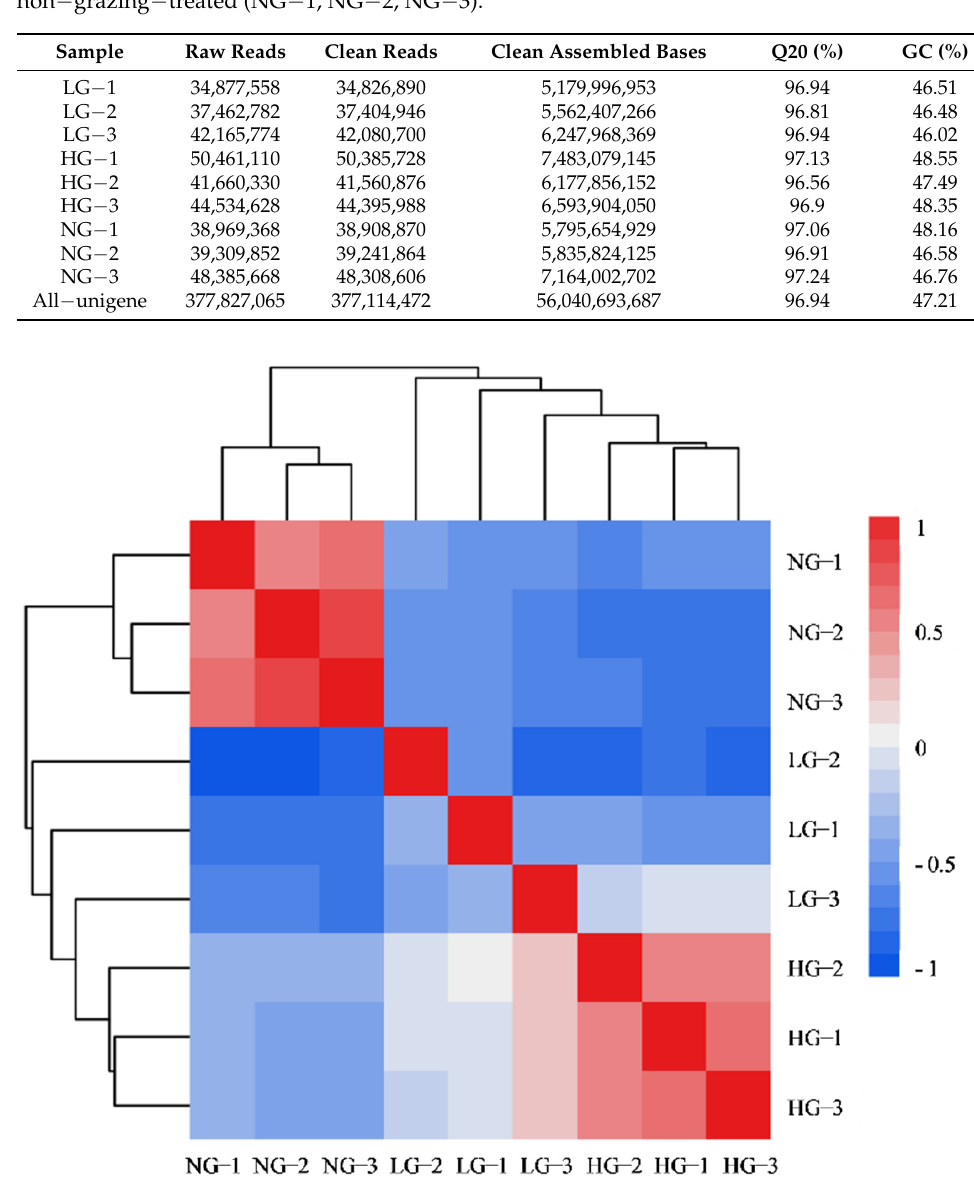
Figure 1. Pearson correlation coefficients of transcript levels in nine samples. NG: non − grazing; LG: light grazing; HG: heavy grazing. Table 1. Sequencing the T. mongolicum transcriptome in nine samples from plants that were light